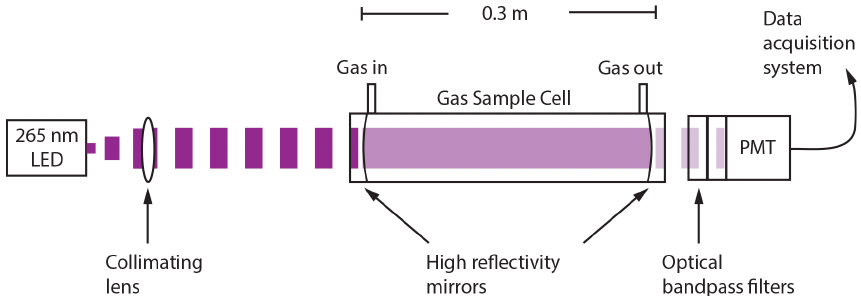
Figure 1. Incoherent broadband cavity-enhanced detection technique for O 3 . An LED at 265nm is collimated with a lens and coupled into the detection cell via high-reflectivity mirrors ( R> 99 . 7%) that comprise the optical cavity and create a long effective optical pathlength. The light attenuated by the sample is then detected using a photomultiplier tube (PMT) operated in analog mode. The sample enters and exits the cell orthogonal to the beam propagation.